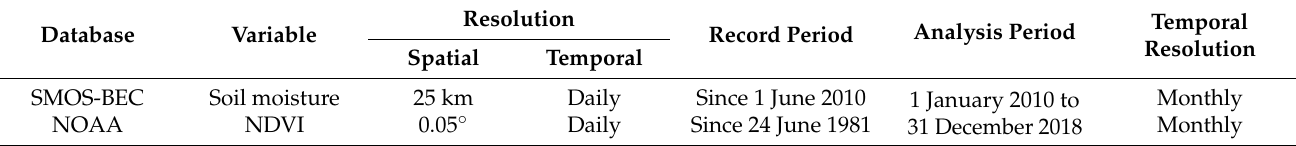
Table 2. Description of the data sets used in this